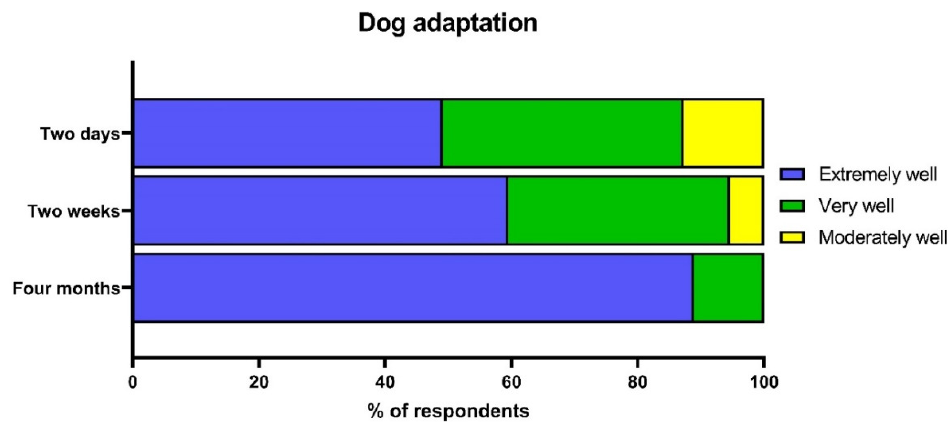
Figure 2. Owners’ perceptions of their dog’s adaptation to the home at two days, two weeks, and four months post-adoption.